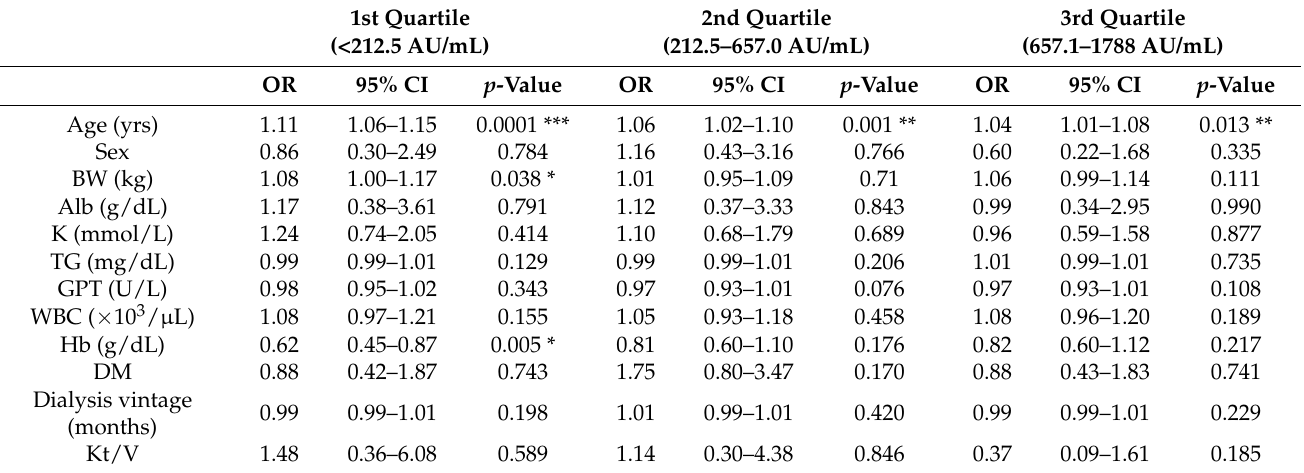
Table 3. Model of antibody levels divided into quartile against clinical variables (Ref. 4th